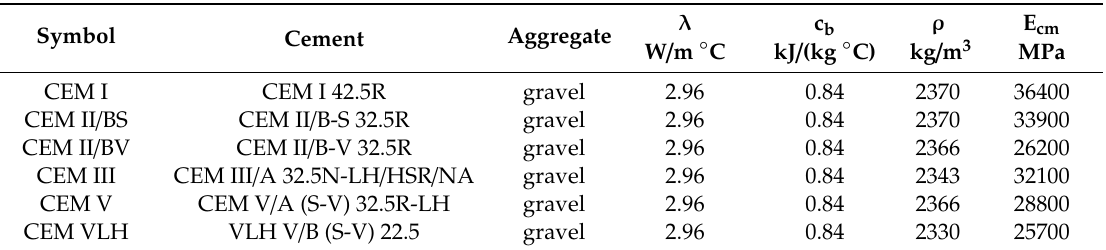
Table 9. Thermo–mechanical properties of concretes used in the FE analysis and analytical calculation.